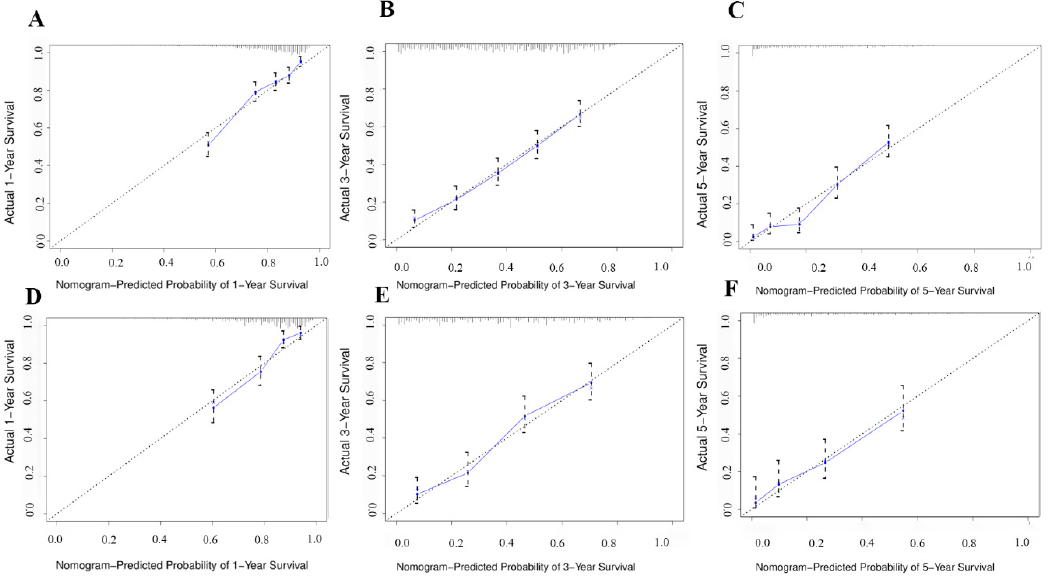
Figure 3. Calibration plots of the nomogram for 1-, 3-, and 5-year CSS prediction in the training set ( A – C ) and validation set ( D – F ).